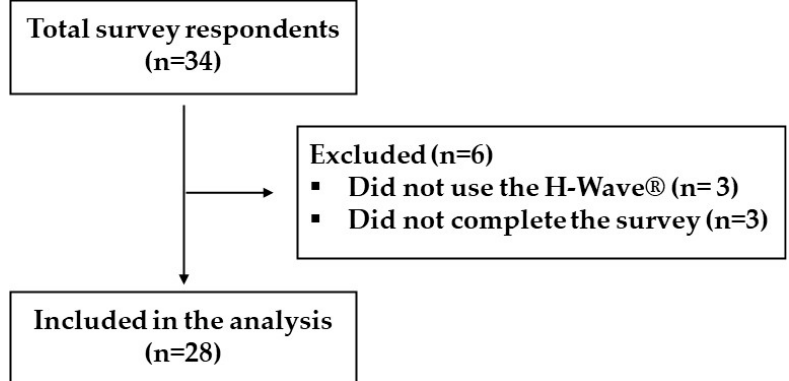
Figure 1. Inclusion flow diagram.